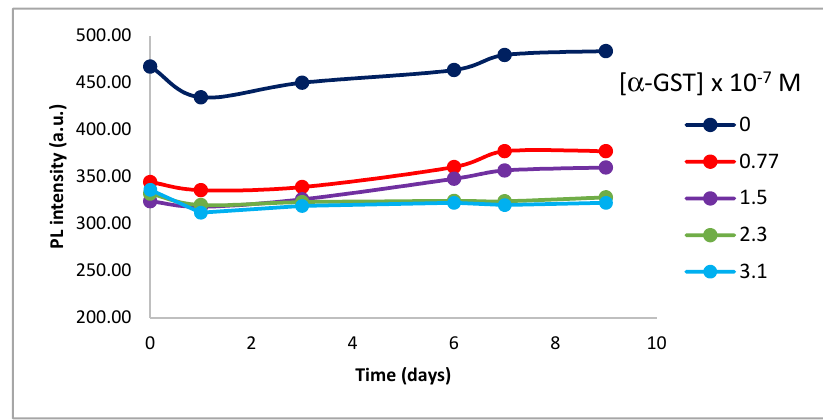
Figure8. CdS-BSA- α -GSTinteraction. Variationinfluorescenceforthedi ff erentantibodyconcentrations Figure 8. CdS-BSA- α -GST interaction. Variation in fluorescence for the different antibody studied. Concentration of CdS-BSA: 2.7 × 10 − 6 mol / L. Concentration of α -GST: Range from 7.7 × 10 − 8 mol / L concentrations studied. Concentration of CdS-BSA: 2.7 × 10 − 6 mol/L. Concentration of α -GST: Range to 3.1 × 10 − 7 mol / from 7.7 × 10 − 8 mol/L to 3.1 × 10 − 7 mol/L.